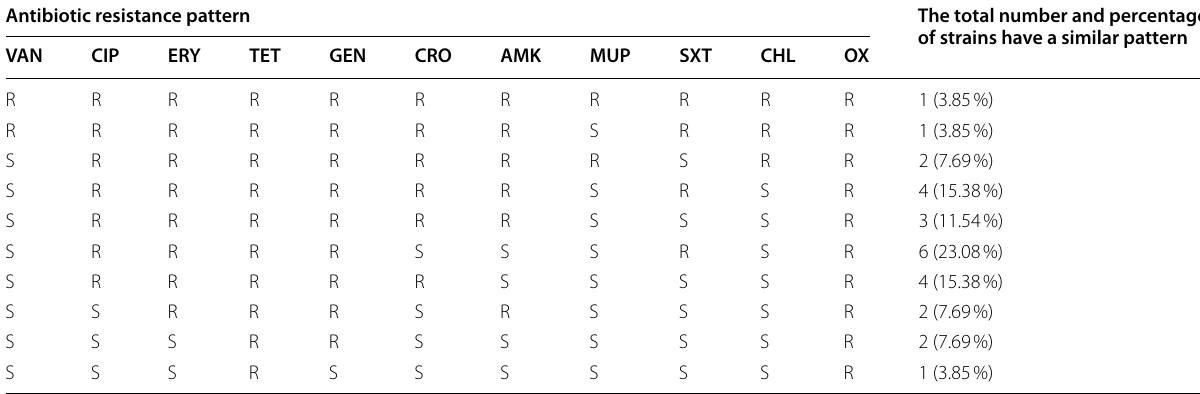
Table 3 Antibiotic resistance pattern in MRSA isolated from clinical samples. It shows the number of strains that have similar antibiotic resistance patterns Antibiotic resistance pattern